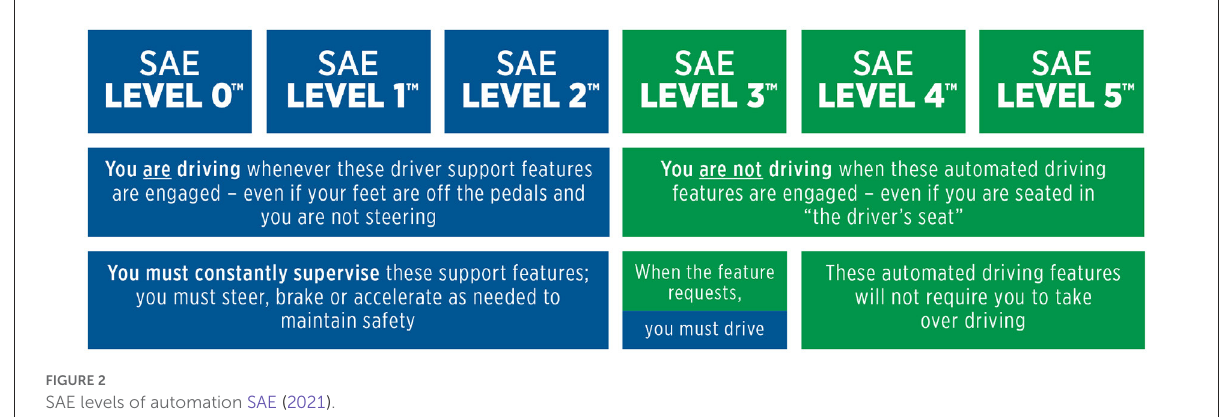
FIGURE2 SAE levels of automation SAE